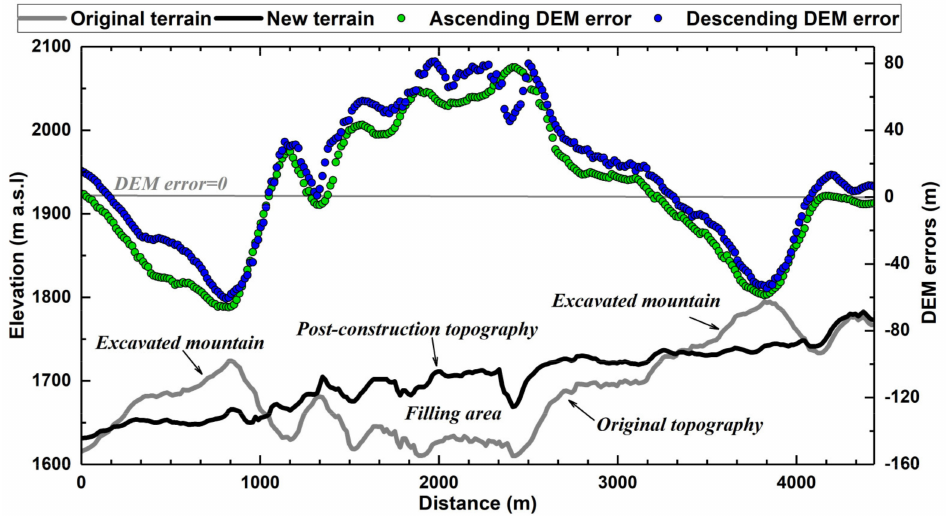
Figure 18. Comparison of terrain elevations before and after creating land and ascending and descending DEM errors along the Profile AA’ marked in Figure